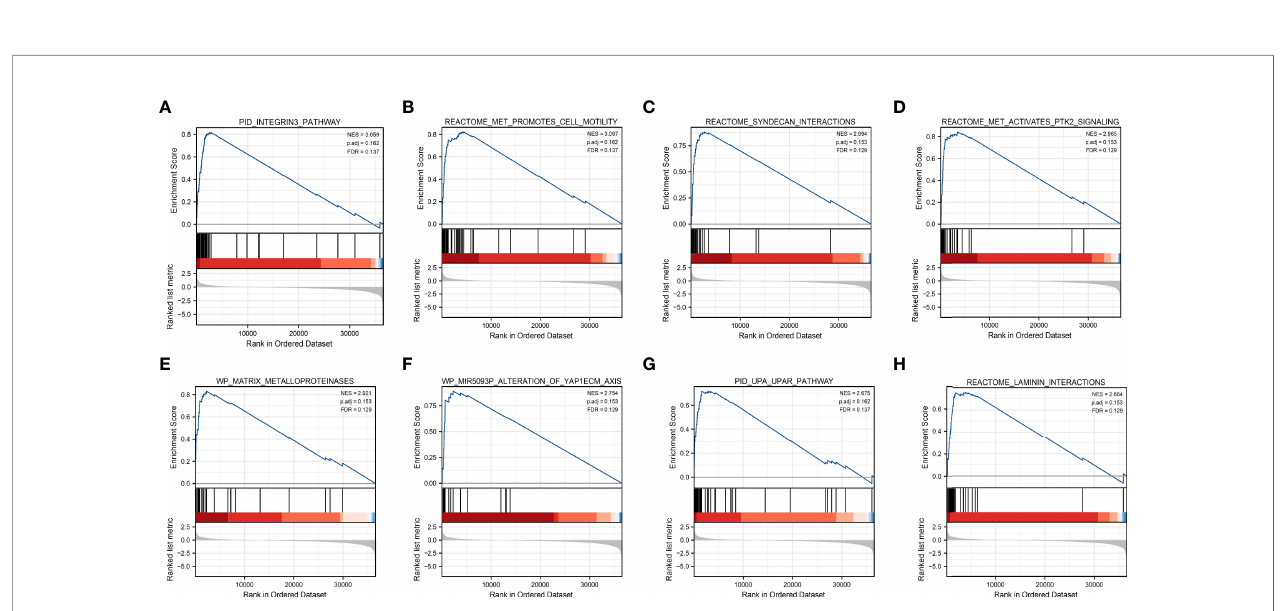
FIGURE 4 | Protein – protein interaction network and function enrichment in HNSCC. (A, B) DCBLD1 interaction protein plot and description. (C) PPI network of DCBLD1 and its co-expression genes. (D) GO and KEGG enrichment analyses of DCBLD1-related genes.